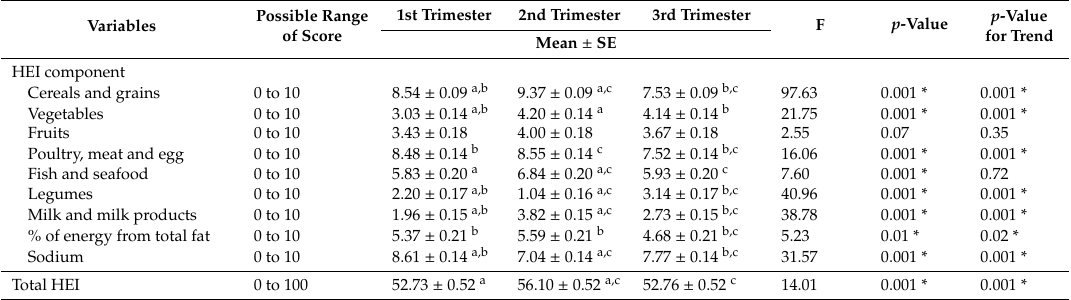
Table 3. Component score and total score for Healthy Eating Index for Malaysians (HEI) by trimester of pregnancy.